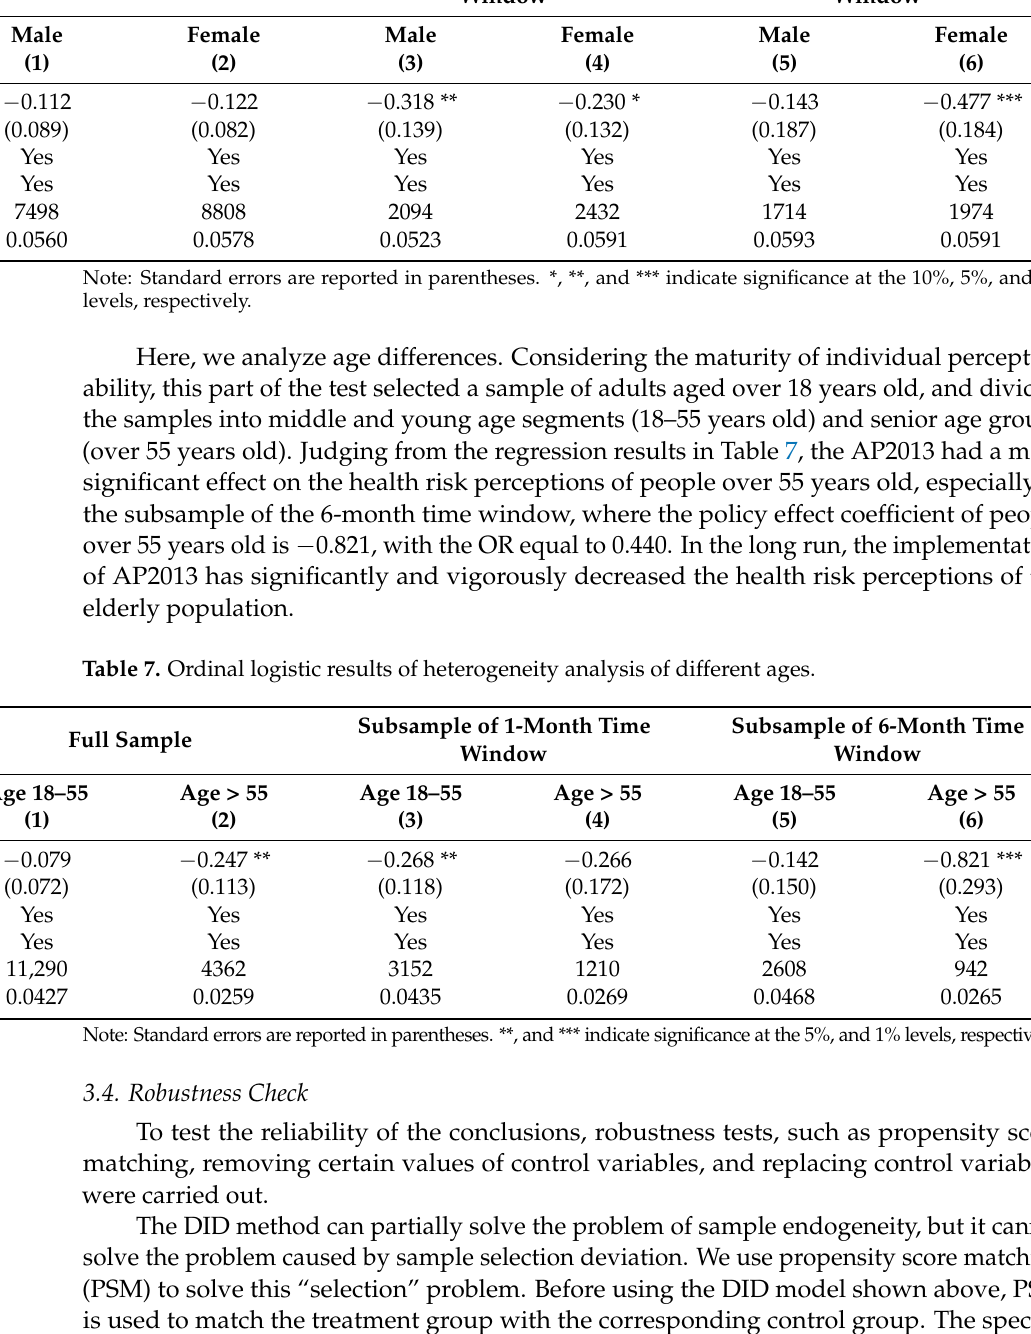
Table 6. Ordinal logistic results of heterogeneity analysis of gender. Full Sample